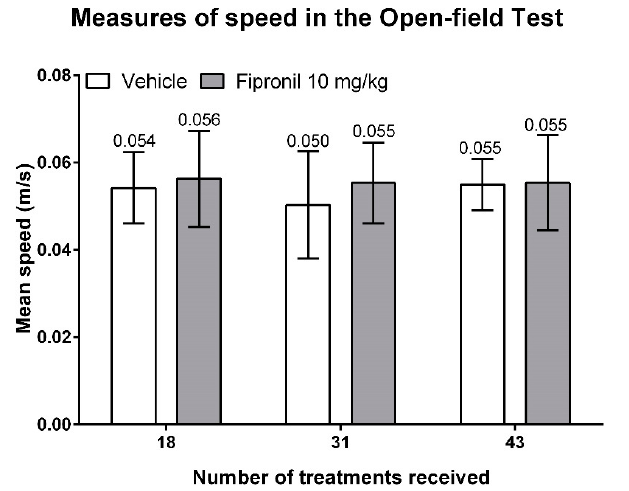
Figure 3. Mean speed during the 30 min of free exploration during the three sessions of open-field testing as a function of the number of treatments. Mean speed displayed by the animals in meters travelled per second (Y axis) as a function of the number of treatments (X axis). Mean values are indicated above the corresponding bars. Neither treatment type nor treatment duration had a significant effect on the mean speed of mice.